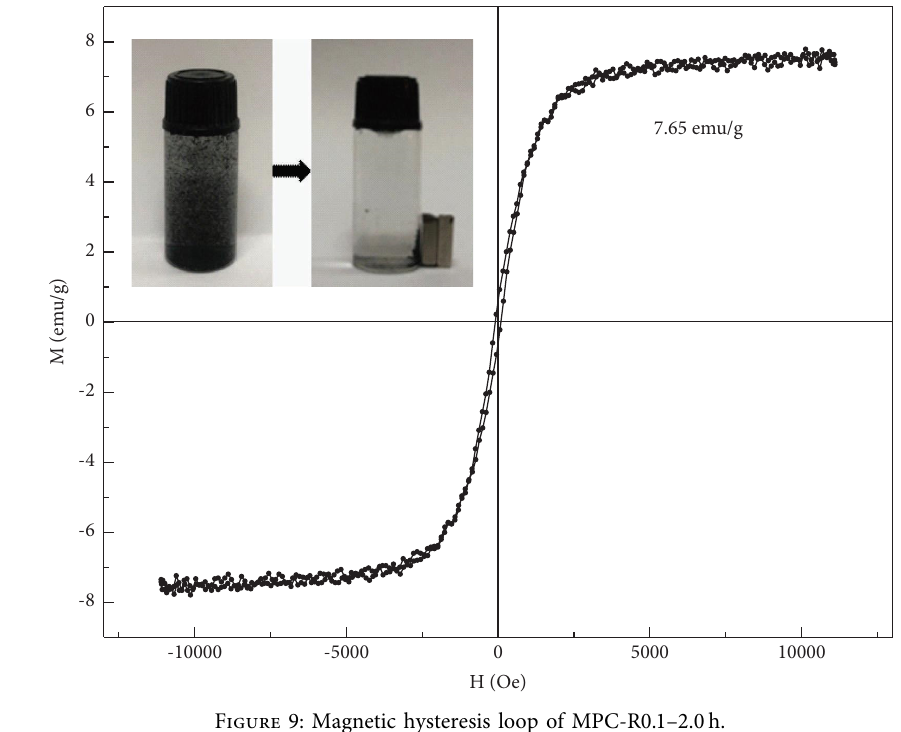
Figure 9: Magnetic hysteresis loop of MPC-R0.1–2.0 h.